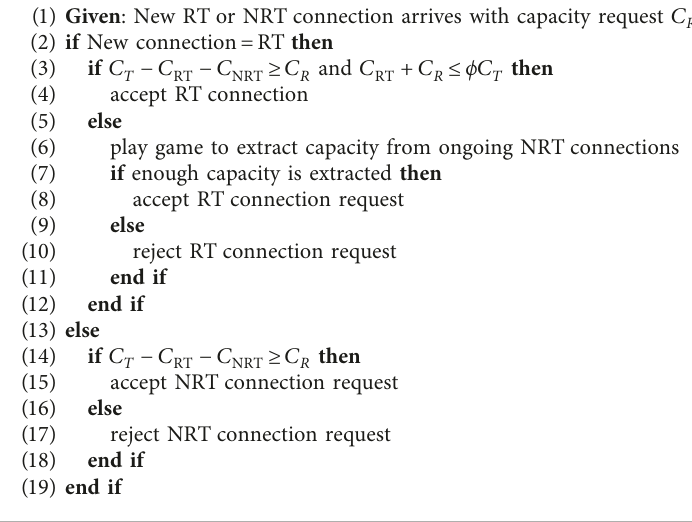
A LGORITHM 1: CAC